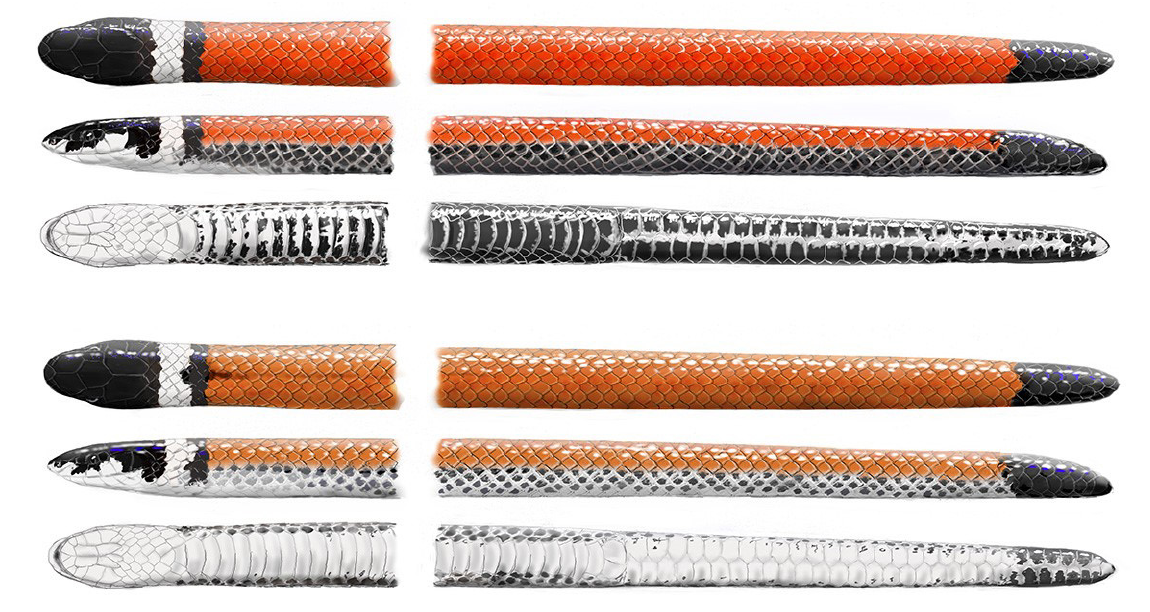
Fig. 2. Apostolepis albicollaris Lema, 2002, coloration in life and polymorphism. Holotype of A. albicollaris from Brasília, Distrito Federal, Brazil (MCP 8355) (top). Holotype of Apostolepis cerradoensis Lema, 2003 from Minaçu, Goiás, Brazil (MCP 15219) (bottom). Drawings: Arthur